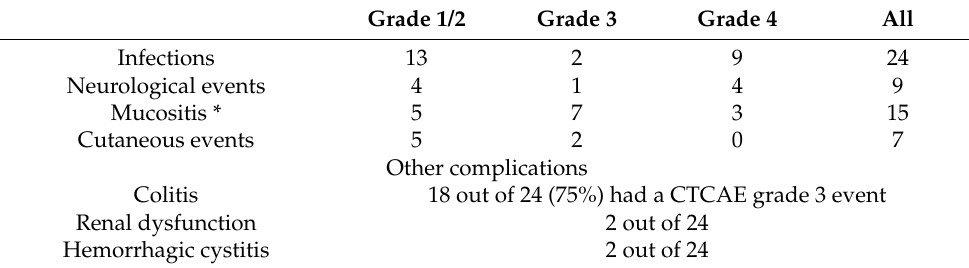
Table 2. Adverse events, according to the CTCAE